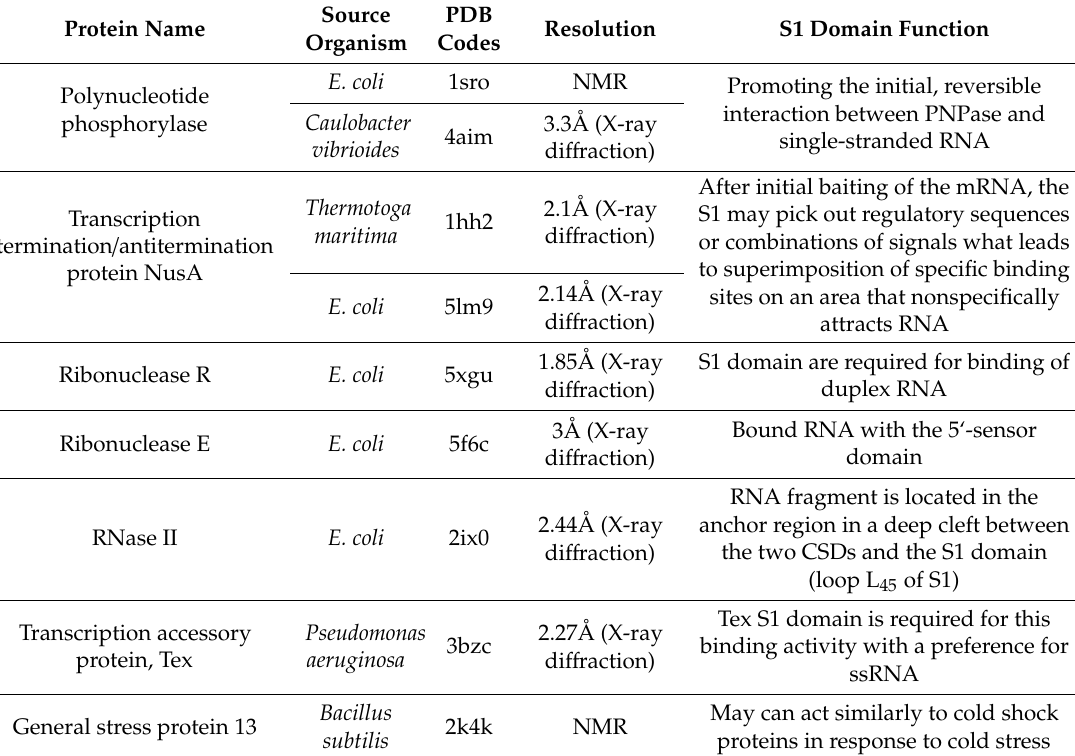
Table 1. Bacterial proteins containing the S1